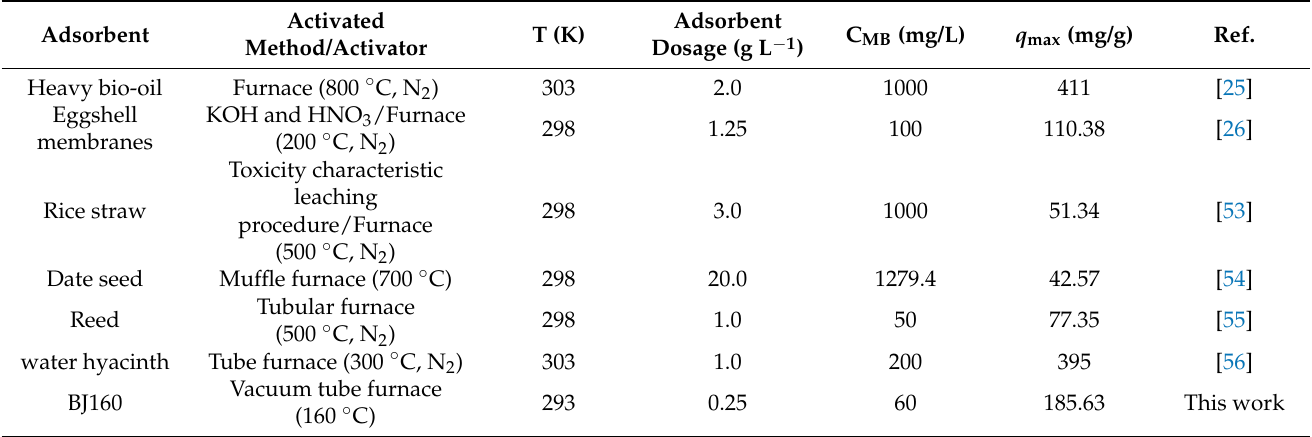
Table 1. A comparison of adsorption capacities of BJ160 toward MB with other previously reported carbon-based adsorbents under optimal experimental